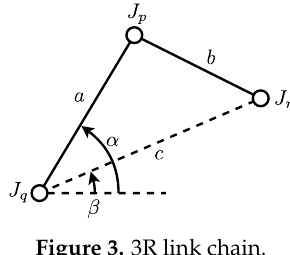
Figure 3. 3R link chain.